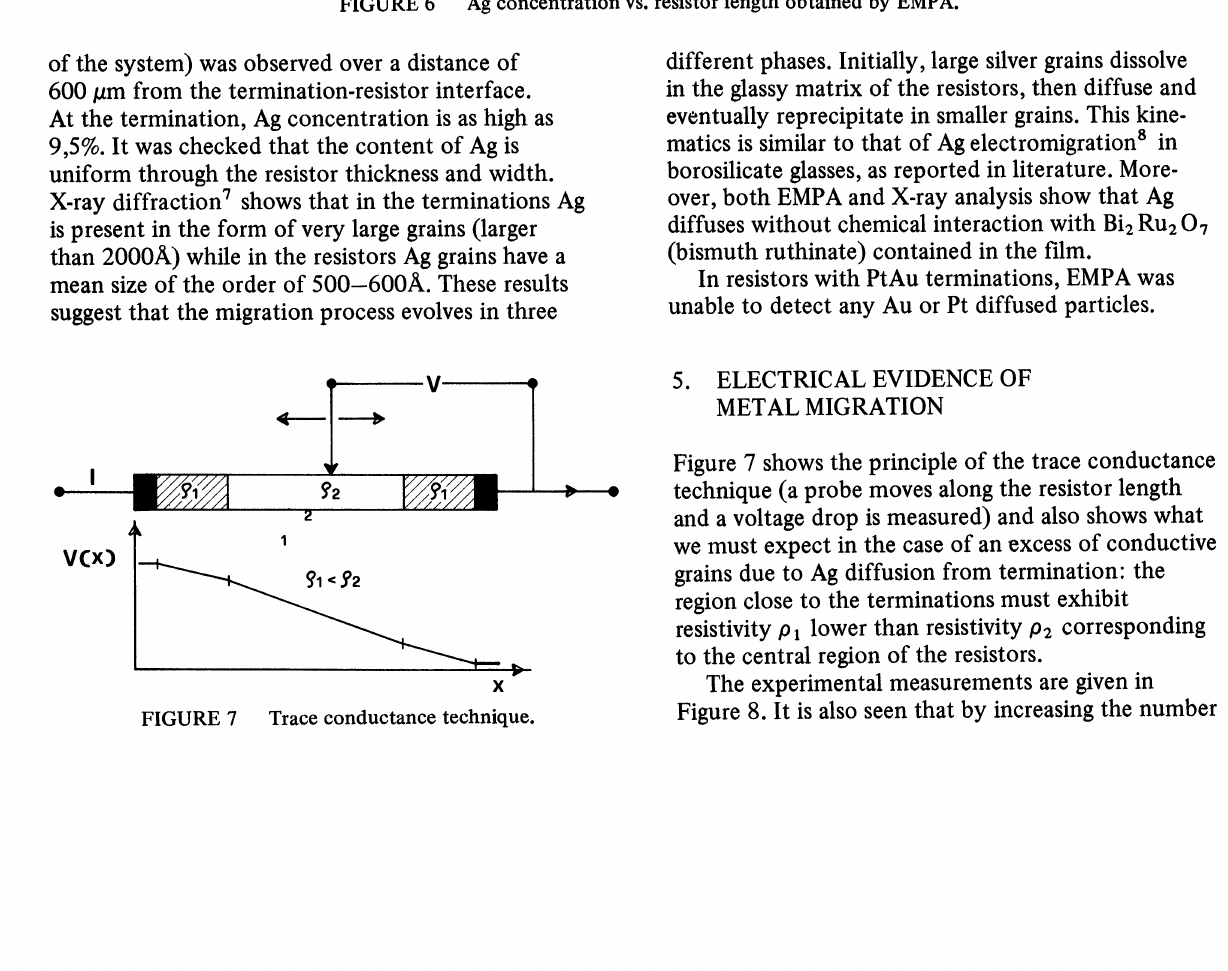
FIGURE 6 Ag concentration vs. resistor length obtained by EMPA.